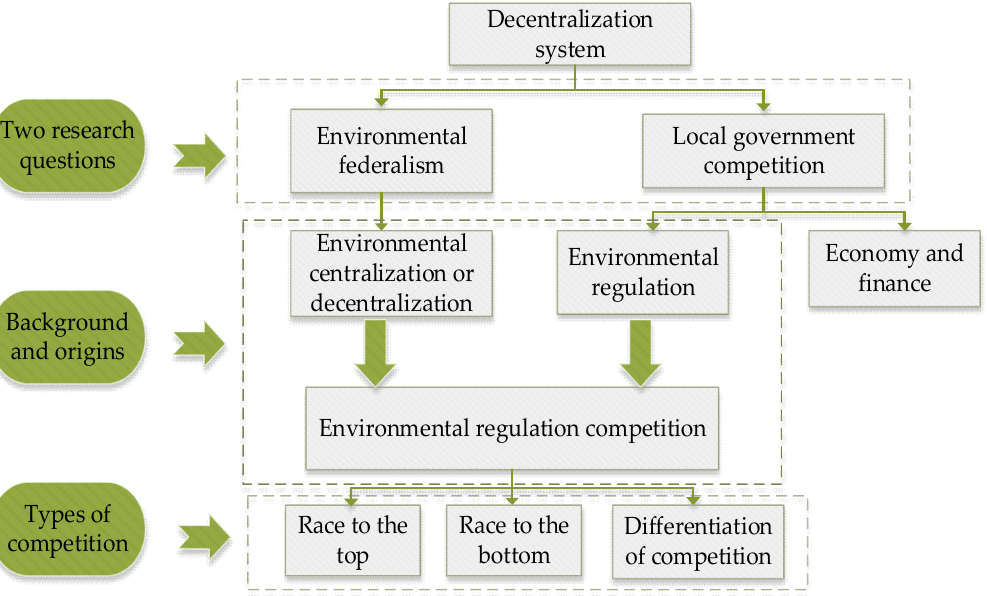
Figure 1. Logic diagram of environmental regulation competition theory.